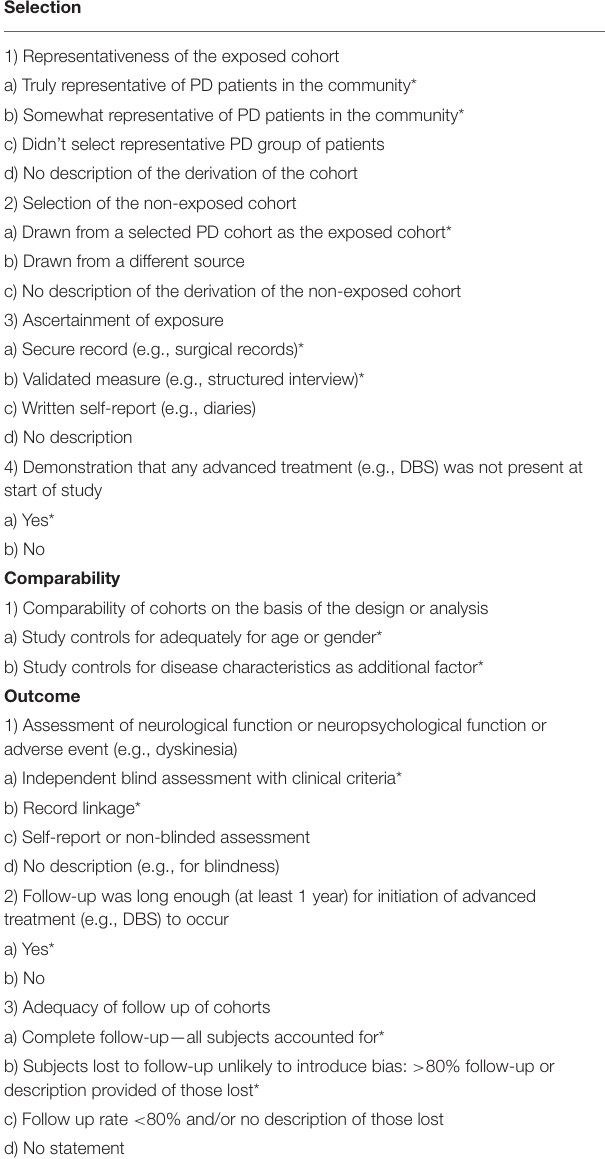
TABLE 1 | Newcastle-Ottawa quality assessment scale for cohort studies